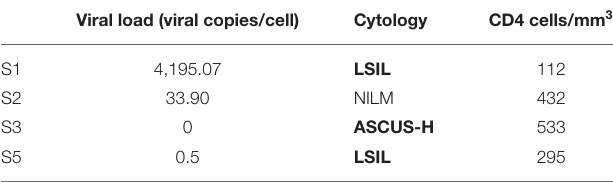
TABLE 6 | HPV-18 viral loads, cytology, and CD4 count. Viral load (viral